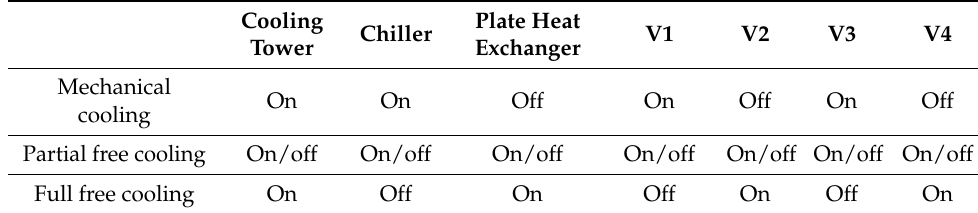
Table 2. Equipment and valve operating status in parallel system